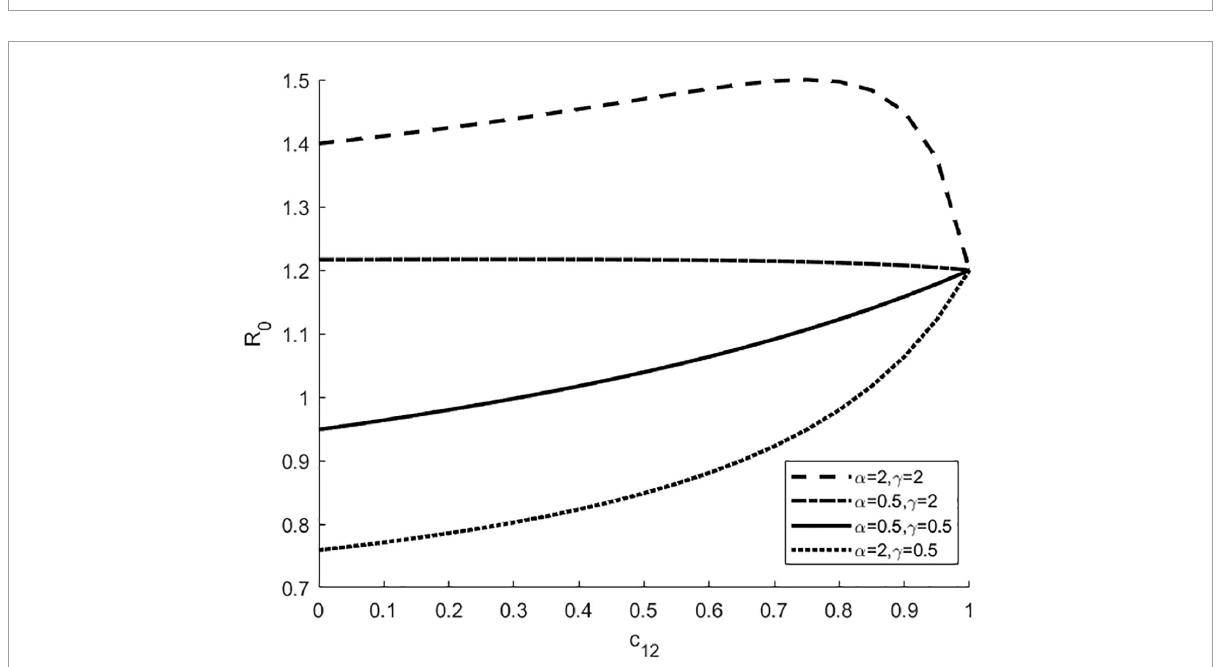
FIGURE2 R 0 according to interspecific competition coefficient c 12 in the presence of vector preference and differences in host competence. The four lines represent four different combinations of vector preferences α and transmission ratios γ . Here c 21 = 0 . 5, b max = 0.3, K 1 = K 2 = 1000, K v = 4000, (cid:48) v = 0 . 1, g 2 = 0 .